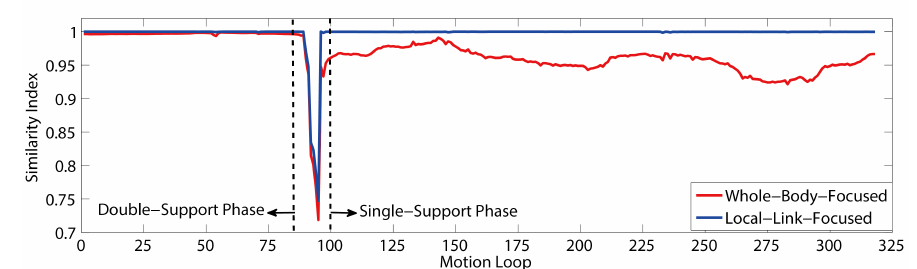
Figure 14. Left-thigh similarity index trajectories in the first experiment as calculated using the two evaluation